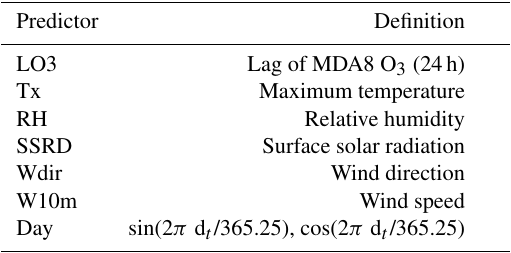
Table 2. List of the predictors used in the multiple linear regres- sion analysis: meteorological parameters, lag of MDA8 O 3 (24h, previous day) and the seasonal cycle components.